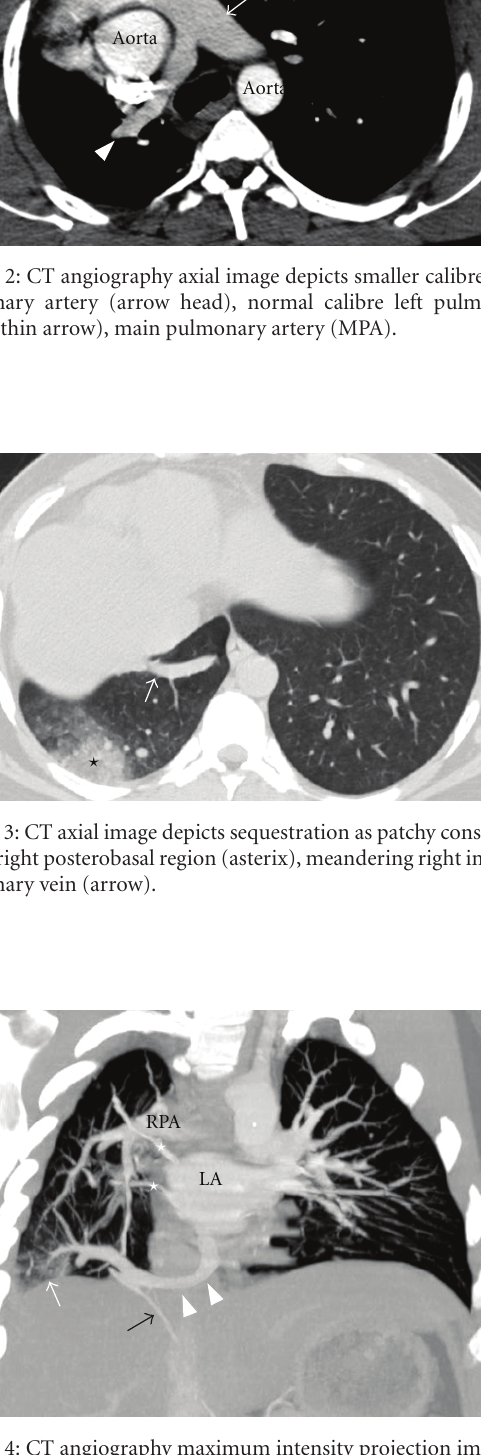
Figure 4: CT angiography maximum intensity projection image in coronal plane depicts right superior and middle pulmonary vein (asterix). Sequestration (white arrow), meandering right inferior pulmonary vein (arrow heads). Anomalous systemic arterial supply (black arrow). Left atrium (LA). Right pulmonary artery